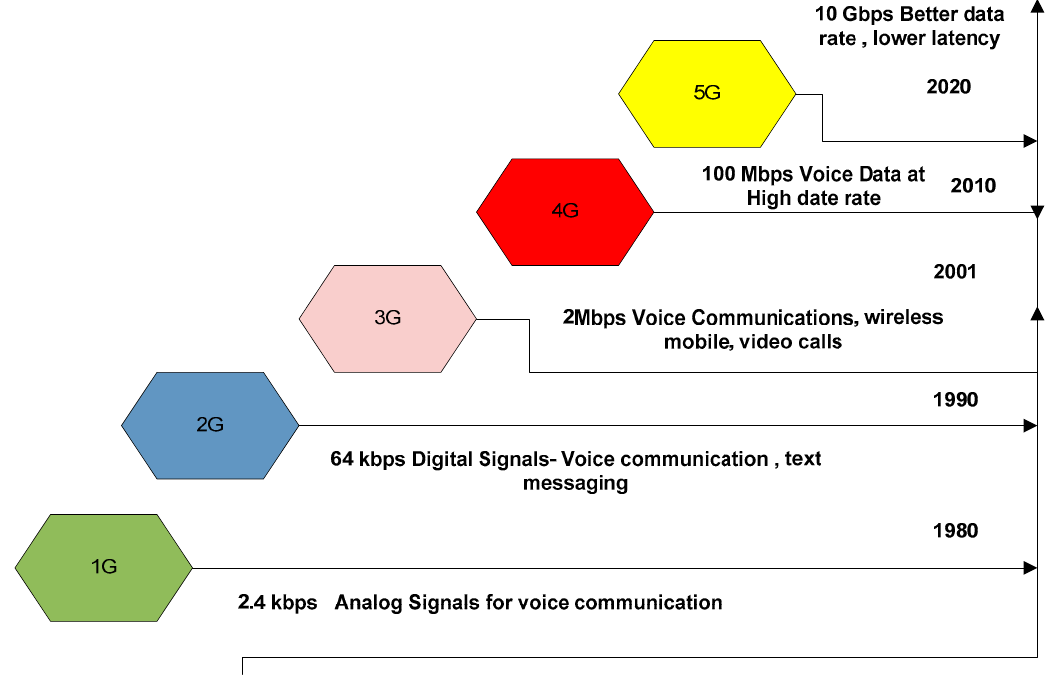
Figure 1. Wireless communications technology and its evolution over the years.